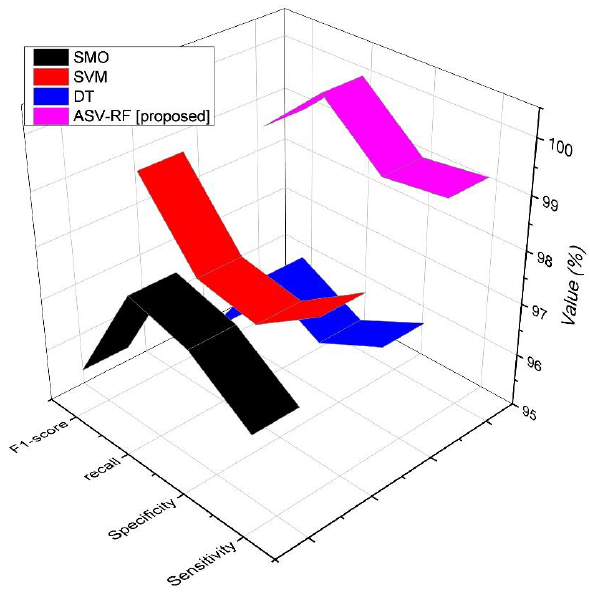
Table 4. Results of Kappa, MAE, and RMSE metrics.